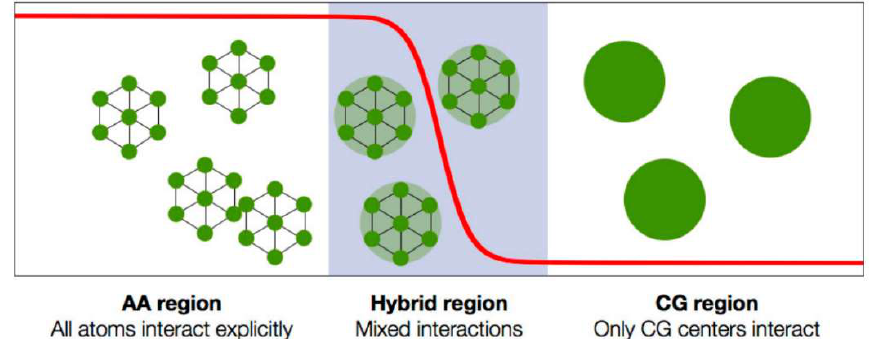
Figure 17. Representation of an adaptive resolution simulation in which a high-resolution fully atomistic (AA) region is coupled to a low-resolution coarse-grained (CG) region. Figure reproduced from Ref. [277] under CC-BY license terms.